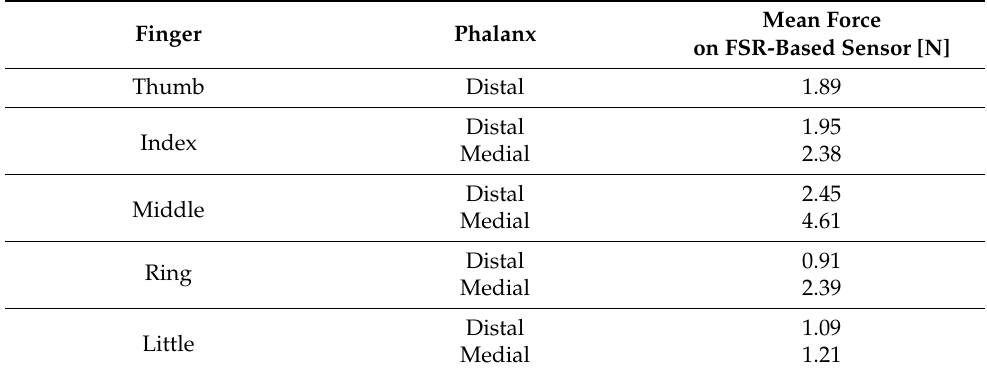
Table 3. Mean forces [N] on the selected phalanxes of the prosthesis measured by means of the FSR-based